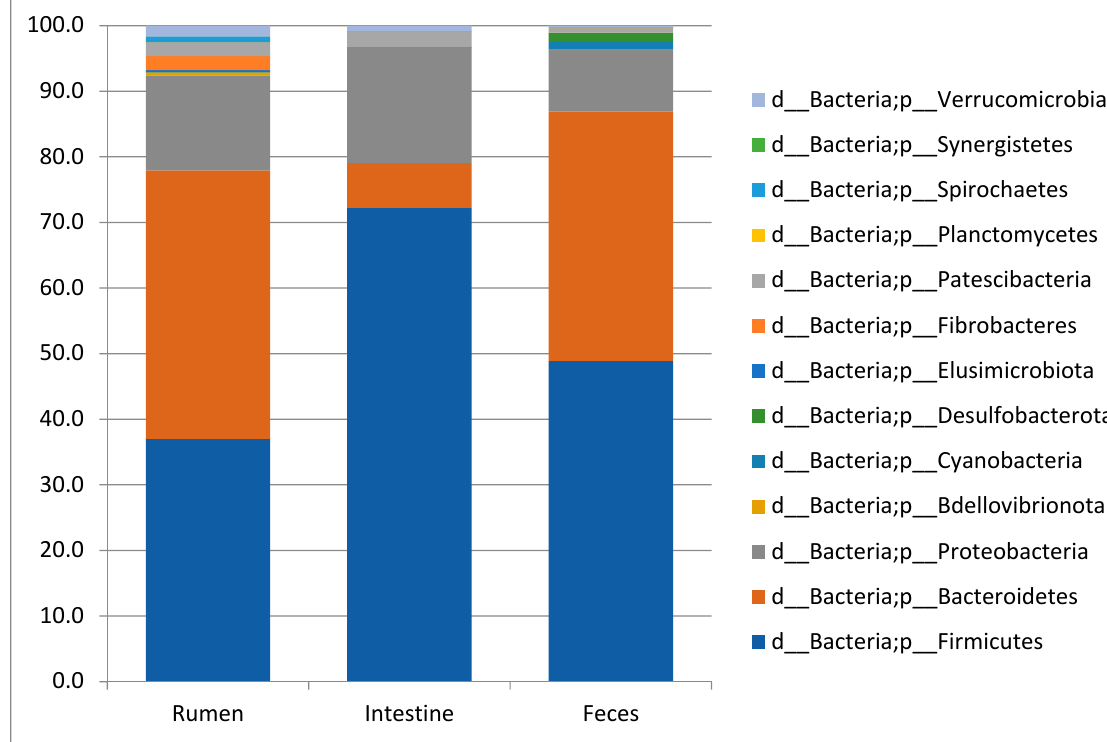
Figure 1. Taxonomy plots at Phylum level of the rumen, large intestine and feces from traditionally fed buffaloes. Relative abundance (mean relative frequency) of the bacterial Phyla identified in different GIT (rumen, large intestine and feces) from traditionally fed water buffaloes ( n = 10). In the taxa list reported on the right of the figure, the letter d_ indicates Domain, p_ indicates Phylum. Table 2. Most abundant Families and Genera found in the analyzed gastrointestinal sites. Relative abundance (mean fre- quency ± SD) of the most abundant Families and Genera observed in the analyzed GIT sites. Genera